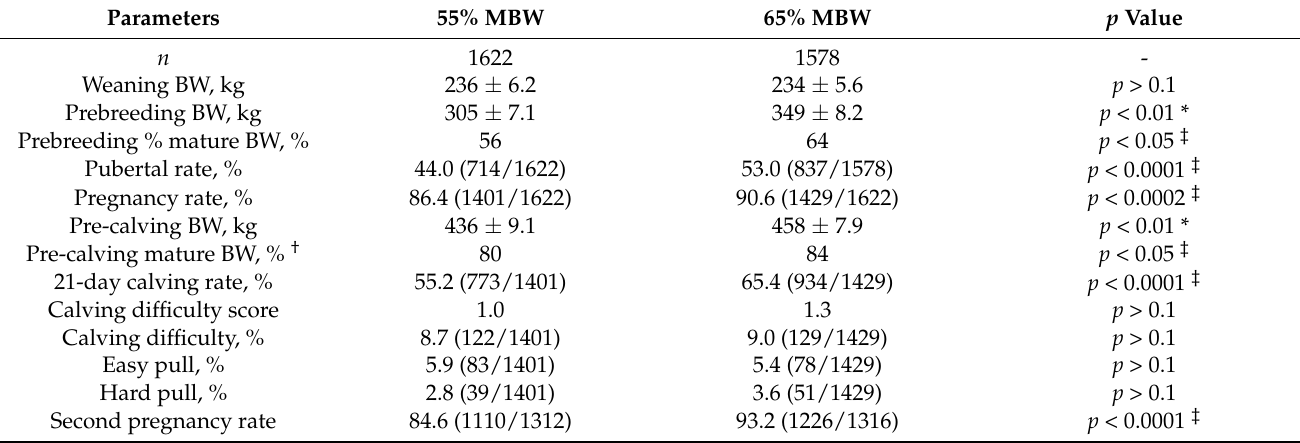
Table 1. Performance of replacement heifers with 55% vs. 65% mature body weight (BW) at breeding.